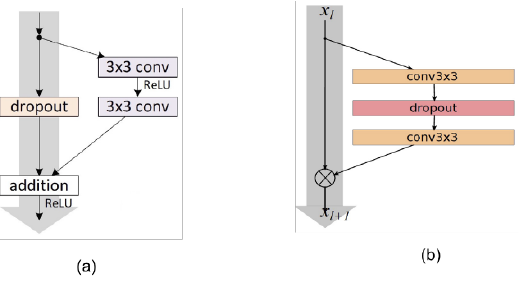
Figure 1. Comparison between (a) Residual Neural Network (ResNet) and (b) Wide Residual Neural Network (WRN) with dropout